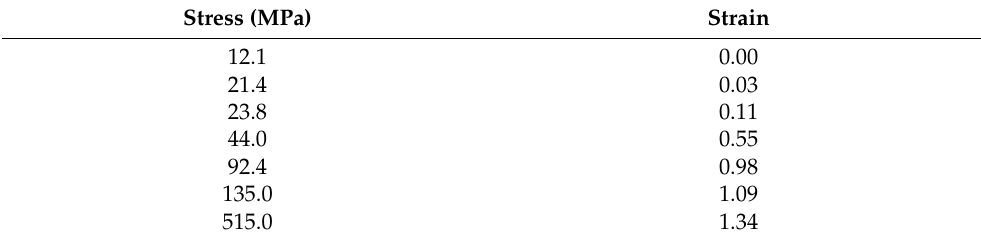
Figure 3. FE model of knee artificial joints. Table 1. The stress–strain data for the J-2 Plasticity model.